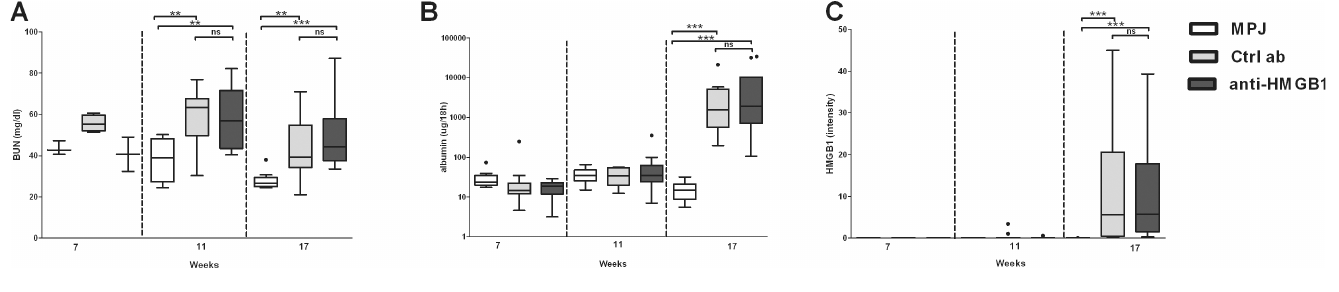
Figure 5. HMGB1 mAb treatment of MRL/lpr mice does not affect albuminuria and HMGB1 urine levels. (A) Renal function was determined by measuring BUN levels at wks 7, 11 and 17. (B) Albumin was measured by ELISA in 18-h urine of MRL/MPJ (n = 10) and MRL/lpr (n = 10–12) mice at wks 7, 11 and 17. (C) HMGB1 was measured by Western blotting in 18-h urine of MRL/MPJ (n = 10) and MRL/lpr (n = 10–12) mice at wks 7, 11 and 17. HMGB1 levels are presented as values of fluorescence intensity and were normalized against a standard of Jurkat cell